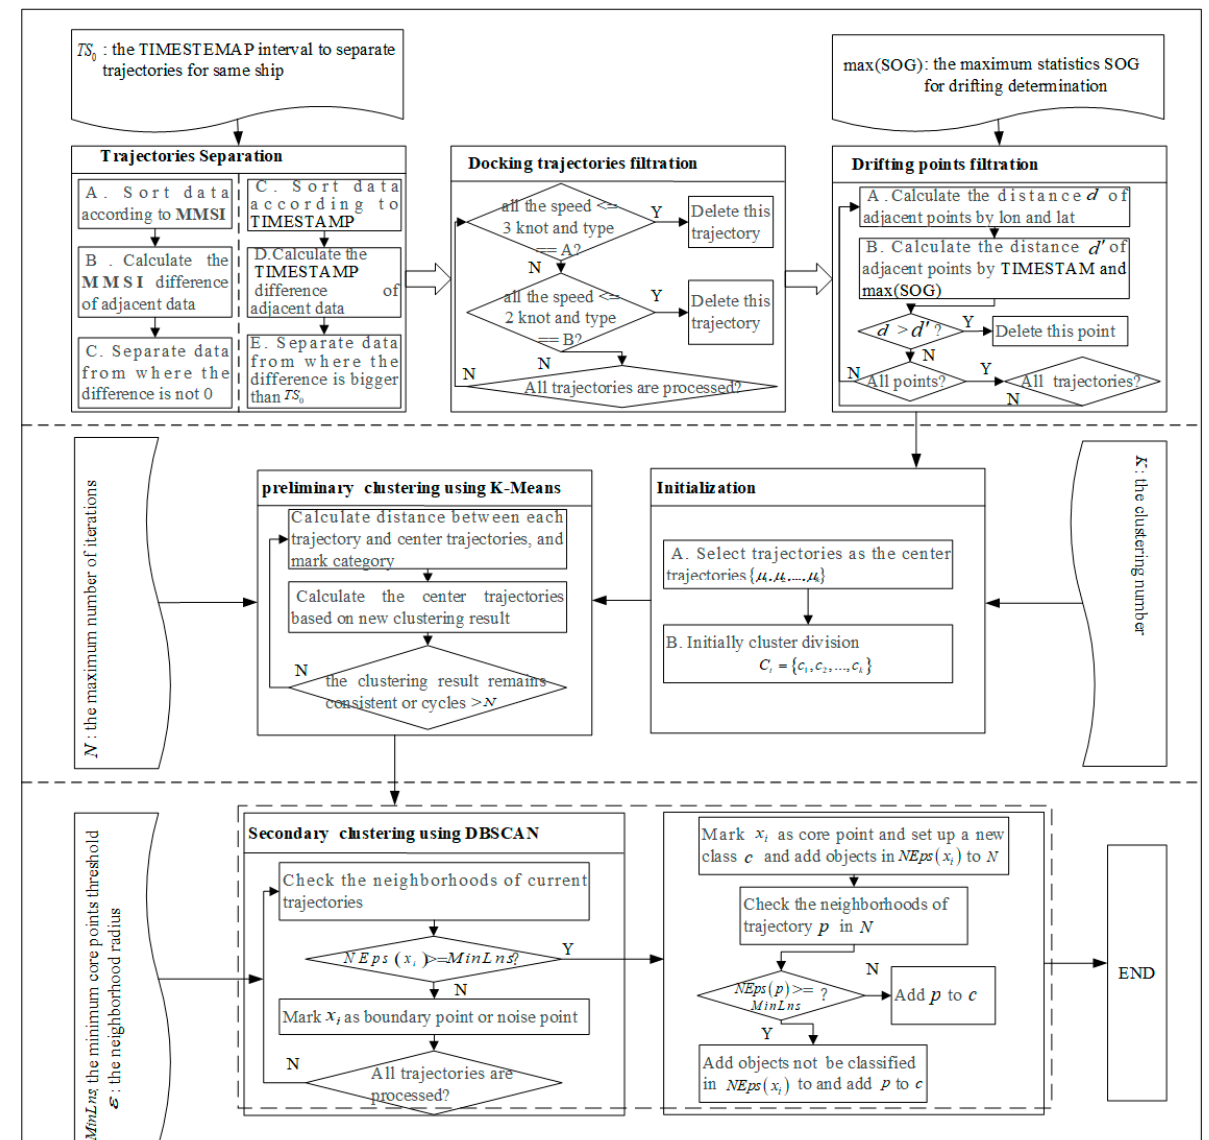
Figure 5. The flowchart of the proposed procedure.